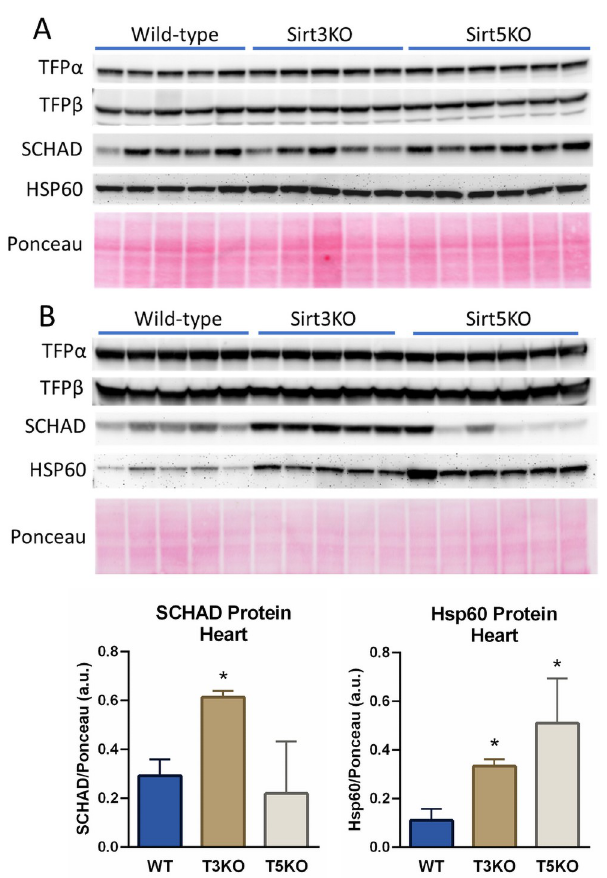
Fig 4. Immunoblotting of SCHAD and TFP in isolated Sirt3KO and Sirt5KO mouse liver and heart mitochondria. Mitochondria isolated from N = 5 wild-type (WT), N = 5 Sirt3KO (T3KO), and N = 6 Sirt5KO (T5KO) mouse livers (A) and hearts (B) were immunoblotted for both subunits of TFP, SCHAD, and mitochondrial heat shock protein-60 (HSP60) as a mitochondrial loading control. Densitometry was used to normalize expression of SCHAD and TFP to both HSP60 and ponceau membrane staining. No statistically significant differences were observed in liver (densitometry results not shown), while in heart differential expression of SCHAD and HSP60 was observed, with densitometry results shown in bar graphs below panel B. Bars represent means and standard deviations, with � P < 0.05 versus wild-type control.